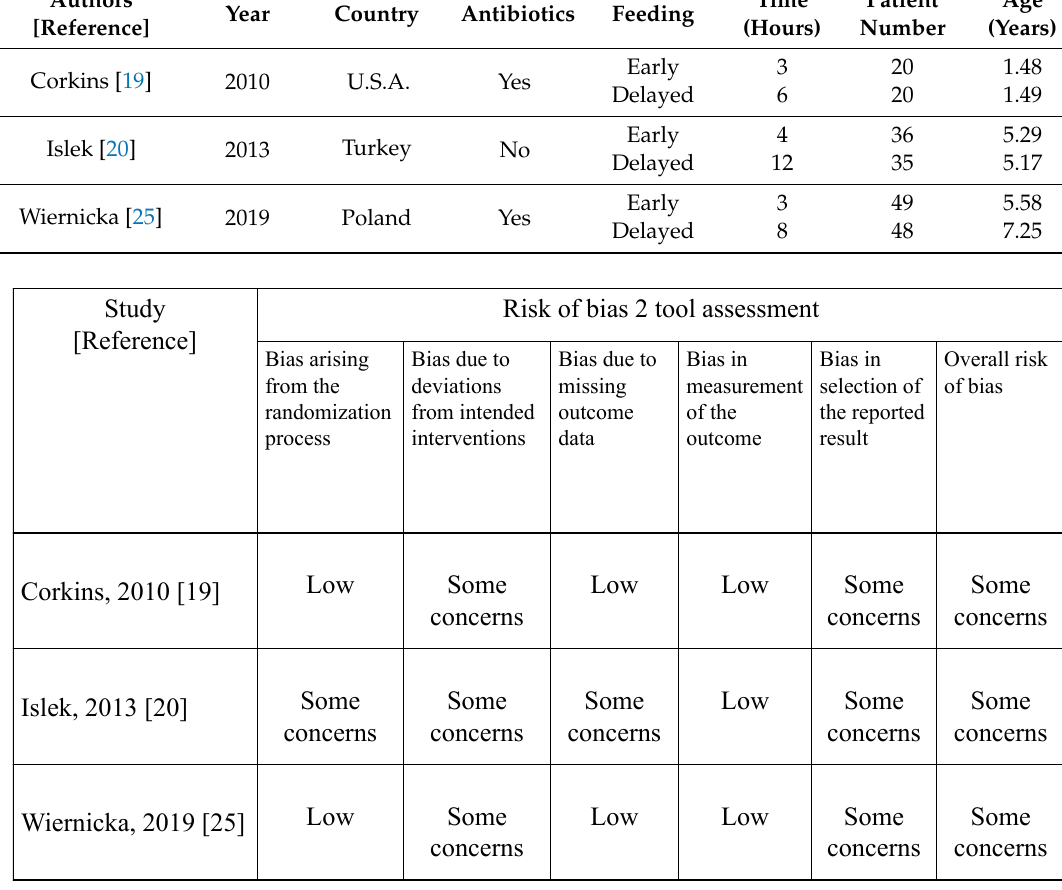
Figure 2. Risk of bias graph and table for mortality within 72